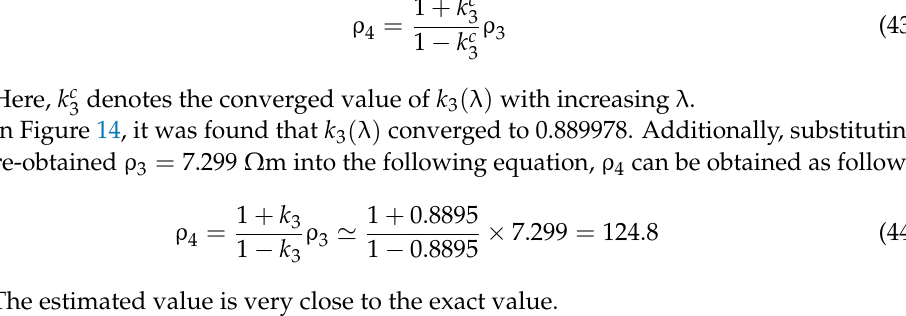
Figure 14.   (λ) according to the different ℎ  . Figure 14. k ( λ ) according to the different h 3 (12) Obtain ρ 4